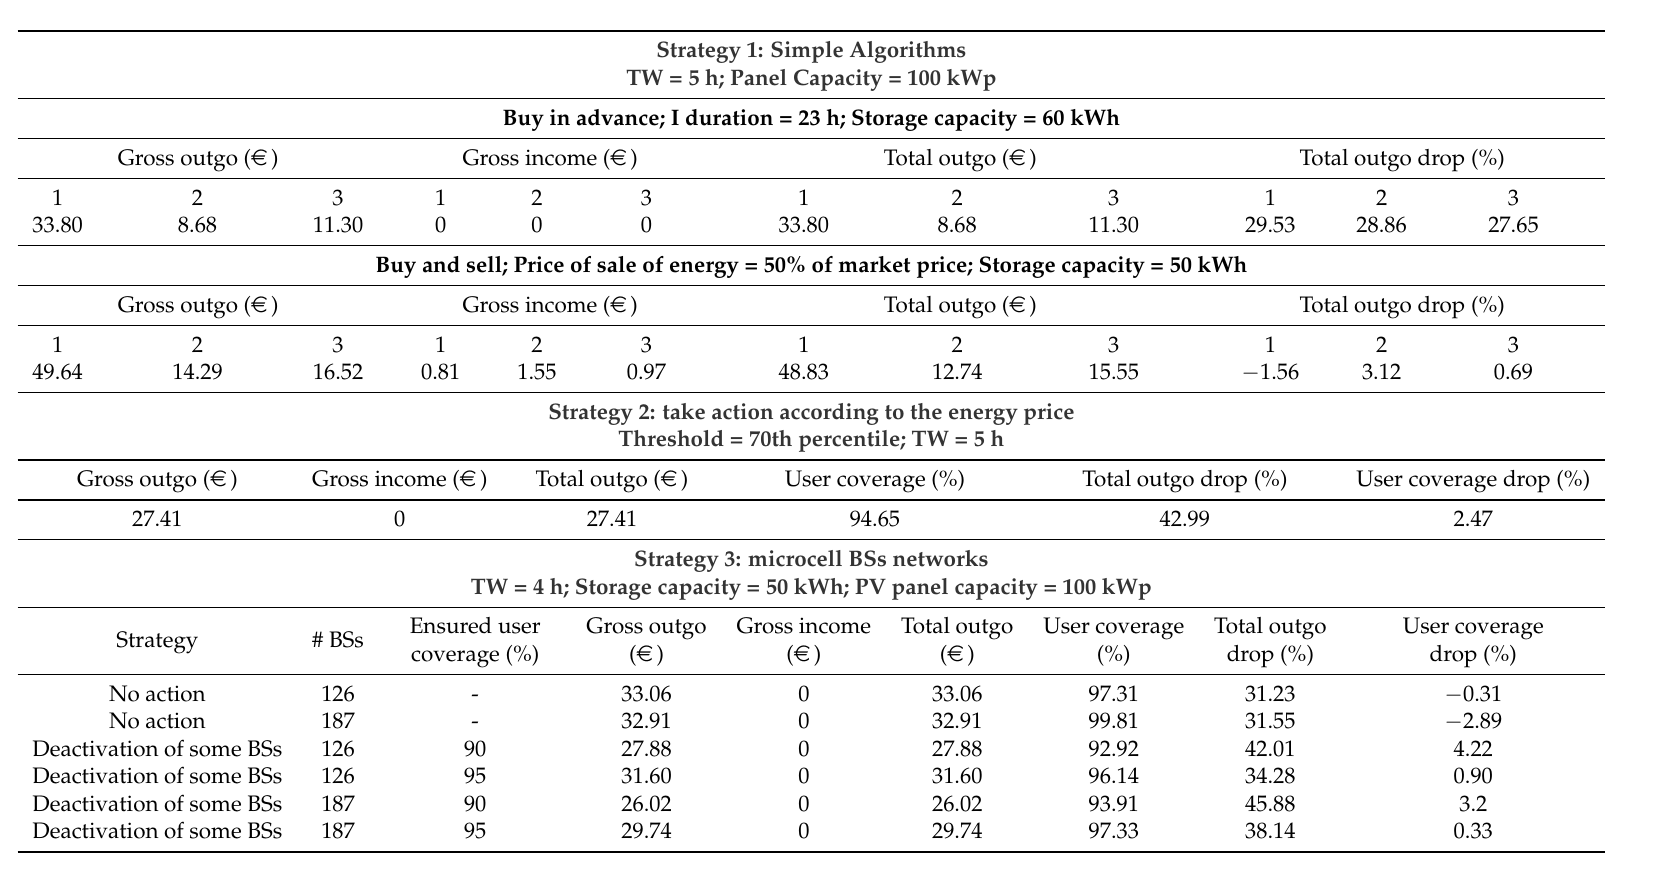
Table 2. Table with the summary of the most significant results. In Strategy 1 (Buy in advance and Buy and sell algorithms), results are reported for each energy reducing strategy: 1 is Undertake no action; 2 is Deactivate all microcell BSs; 3 is Deactivate as much microcell BSs as needed. The parameters setting is indicated in the